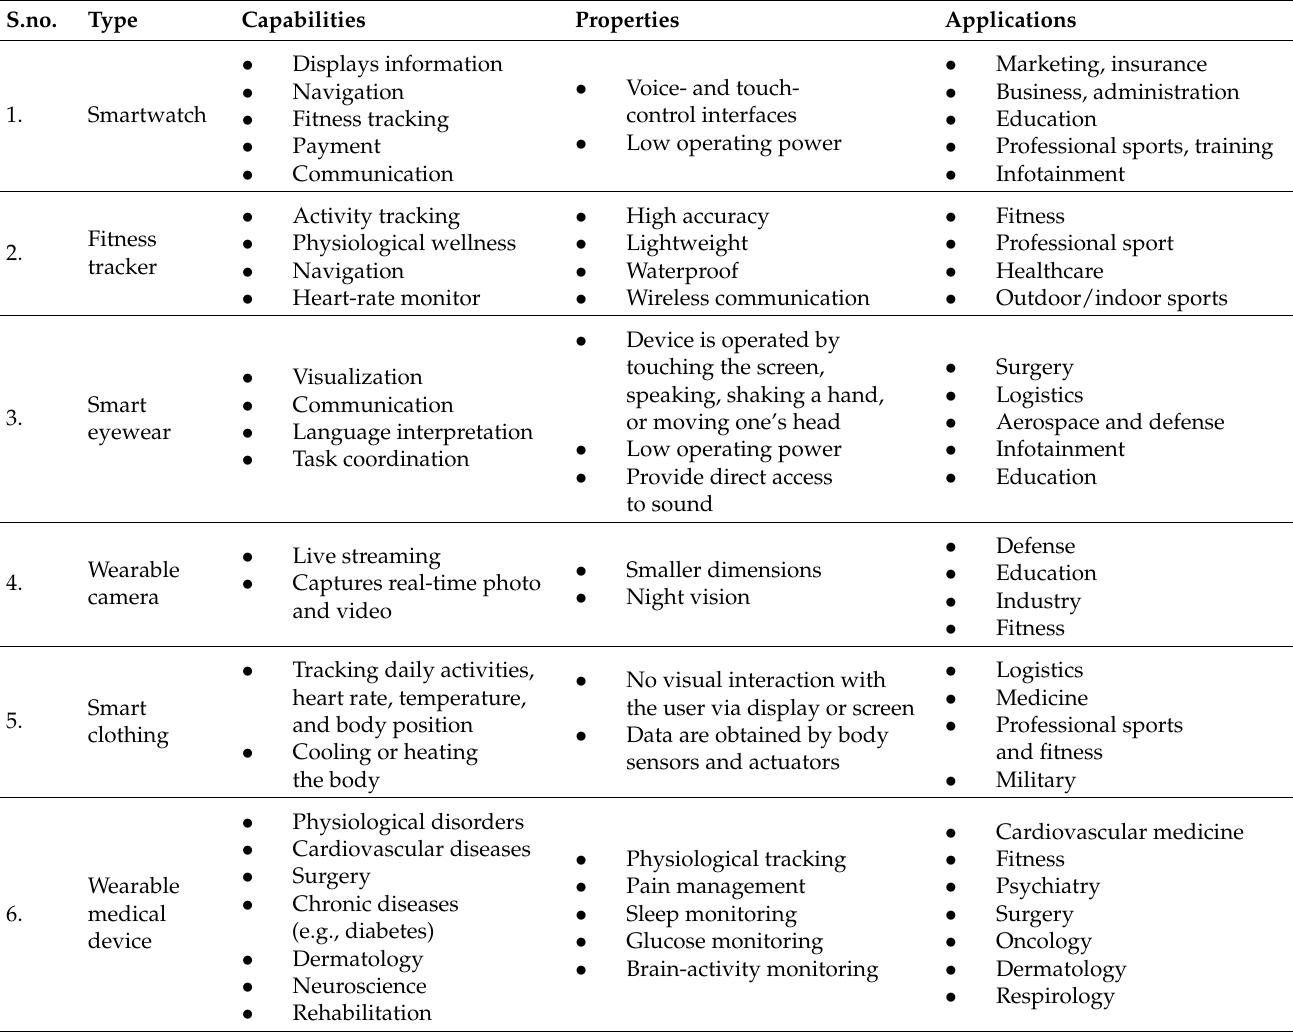
Table 1. Wearable technologies are classified according to their capabilities, properties, and applica- tion